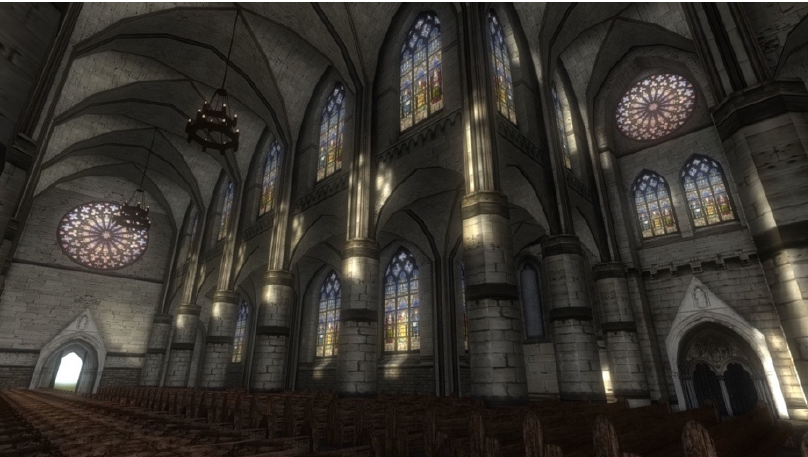
Figure 5. Building type 1 (BT1) church digital model: Back interior view .